Question: Condense the content of this figure into a single sentence.
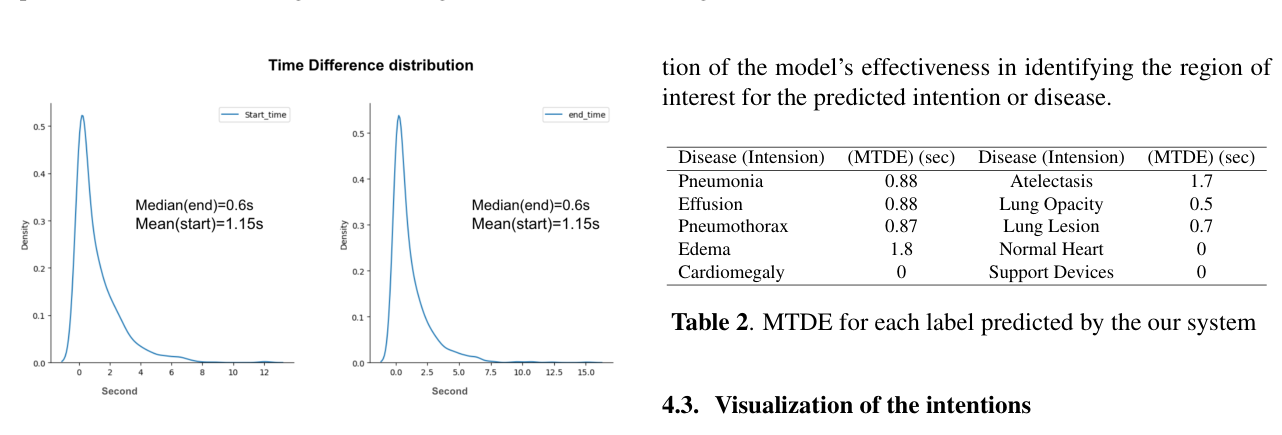
Answer: Distribution plot of differnce between the predicted and true start and end time for each intention in the test set